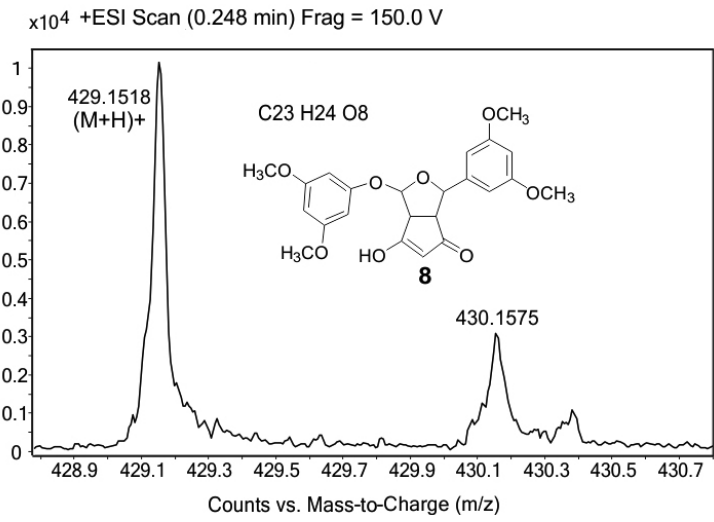
Figure 7. HRMS-ESI spectrum of the crude reaction mixture of 1f after irradiation showing the characteristic signal of dioxygenated bicyclopen- tadione 8